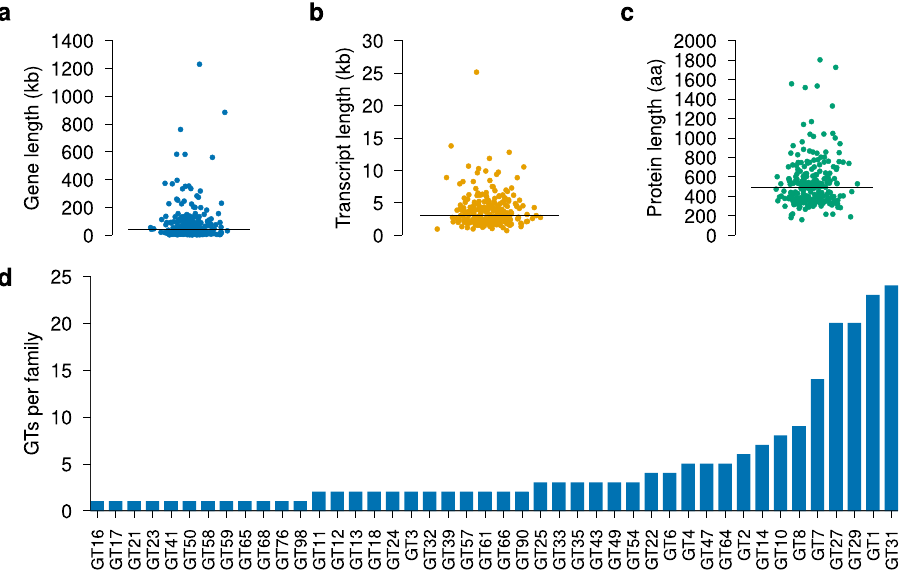
Figure 2. Descriptive data for the identified human GT genes and their transcripts and predicted protein products. (a) The lengths of the GT genes varied considerably, with a median length of 40,799 base pairs (bp) (Supplementary Table 1). The total length of all GT genes was 20,563,185 bp, or 0.7% of the lengths of chromosomes 1–22 and chromosome X in GRCh38 combined. (b) Distribution of lengths for the canonical transcript for each gene and (c) length distribution for the predicted protein product for each of the transcripts in (b) . The lengths of the canonical transcripts were shorter, with a median length of 3,134 bp and a median protein product length of 492 amino acids (aa). (d) Distribution of GT families. Out of the 244 GTs found, 199 (82%) were annotated in Uniprot and the CAZy database as members of at least one GT family (Supplementary Table 1). These GTs were distributed over 44 distinct GT families, GT31 being the most abundant family. The black bar in (a – c) represent the median value for each plot.